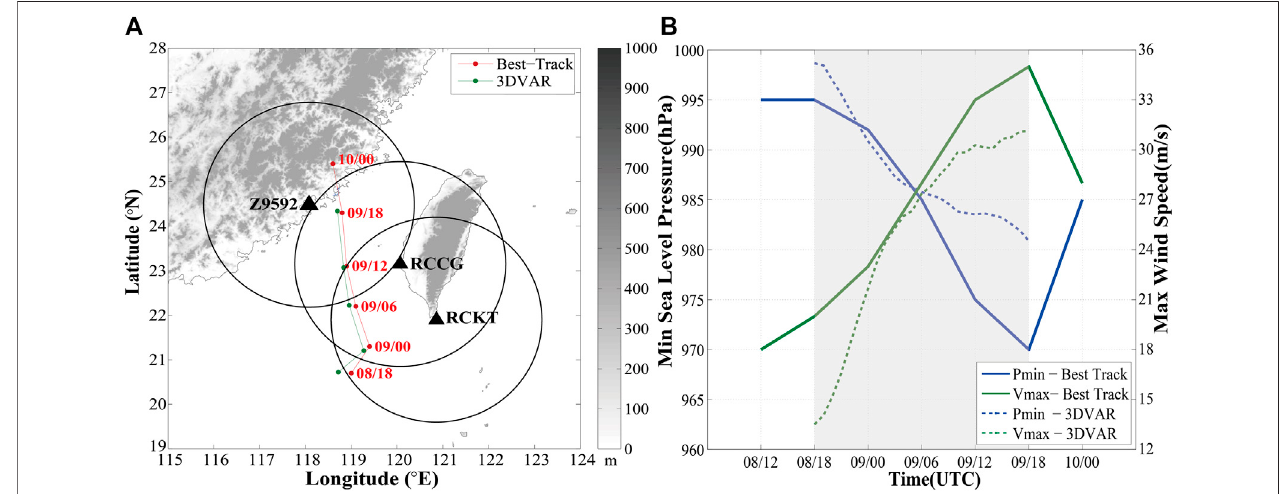
FIGURE 1 | Path and intensity information of Meranti. (A) The analysis domain at 3 km horizontal grid spacing, with the CMA best track (red) and APRS-3DVAR locations (green) of Meranti marked at 6 h intervals from 18:00 UTC September 8, to 0:00 UTC 10 September 2010. (B) The intensity evolution ofTC Meranti, the green (blue) line represents wind speed (sea level pressure), and the solid lines and dotted lines are based on CMA and ARPS-3DVAR,